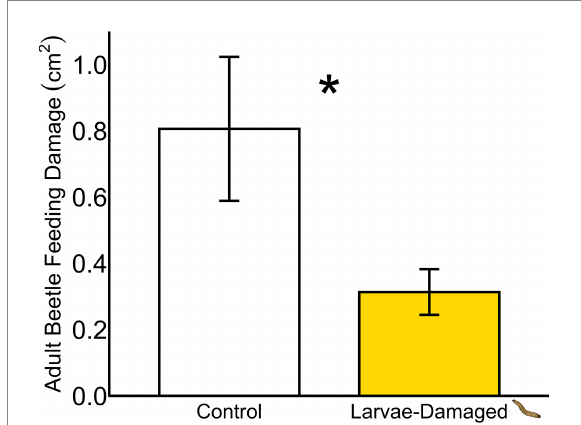
FIGURE 1 Belowground larval herbivory in the field reduces aboveground beetle feeding (* p ≤ 0.05). Means ± SE are